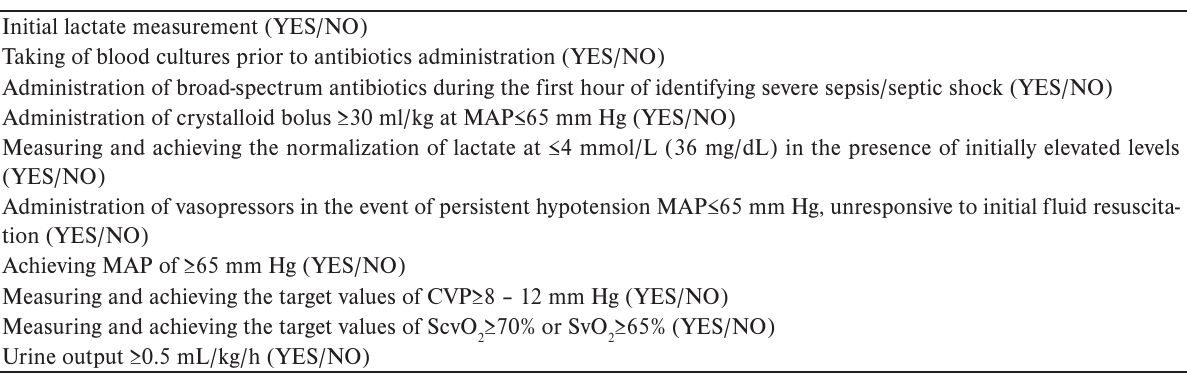
Table 2. The diagnostic and treatment interventions, assessed within the initial 6 h of identifying severe sepsis/septic shock. Initial lactate measurement (YES/NO) Taking of blood cultures prior to antibiotics administration (YES/NO) Administration of broad-spectrum antibiotics during the first hour of identifying severe sepsis/septic shock (YES/NO) Administration of crystalloid bolus ≥30 ml/kg at MAP≤65 mm Hg (YES/NO) Measuring and achieving the normalization of lactate at ≤4 mmol/L (36 mg/dL) in the presence of initially elevated levels (YES/NO) Administration of vasopressors in the event of persistent hypotension MAP≤65 mm Hg, unresponsive to initial fluid resuscita- tion (YES/NO) Achieving MAP of ≥65 mm Hg (YES/NO) Measuring and achieving the target values of CVP≥8 – 12 mm Hg (YES/NO) ≥70% or SvO ≥65% (YES/NO) Measuring and achieving the target values of ScvO 2 2 Urine output ≥0.5 mL/kg/h